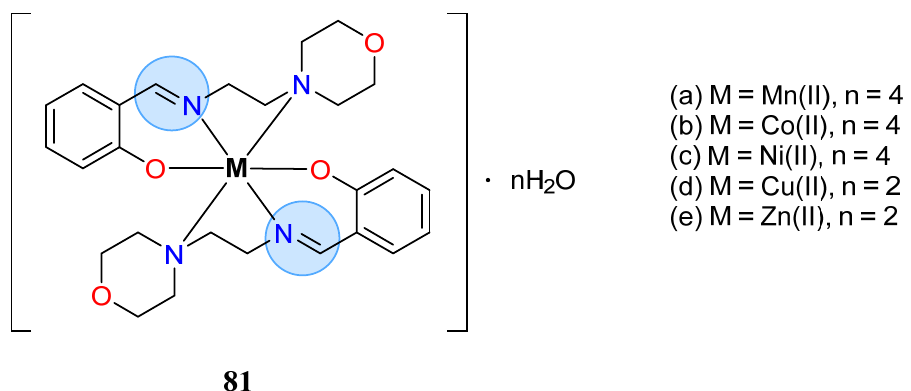
Figure 40. Transition metal(II) complexes from tridentate SB condensed with morpholine with an ‐ timicrobial activity.